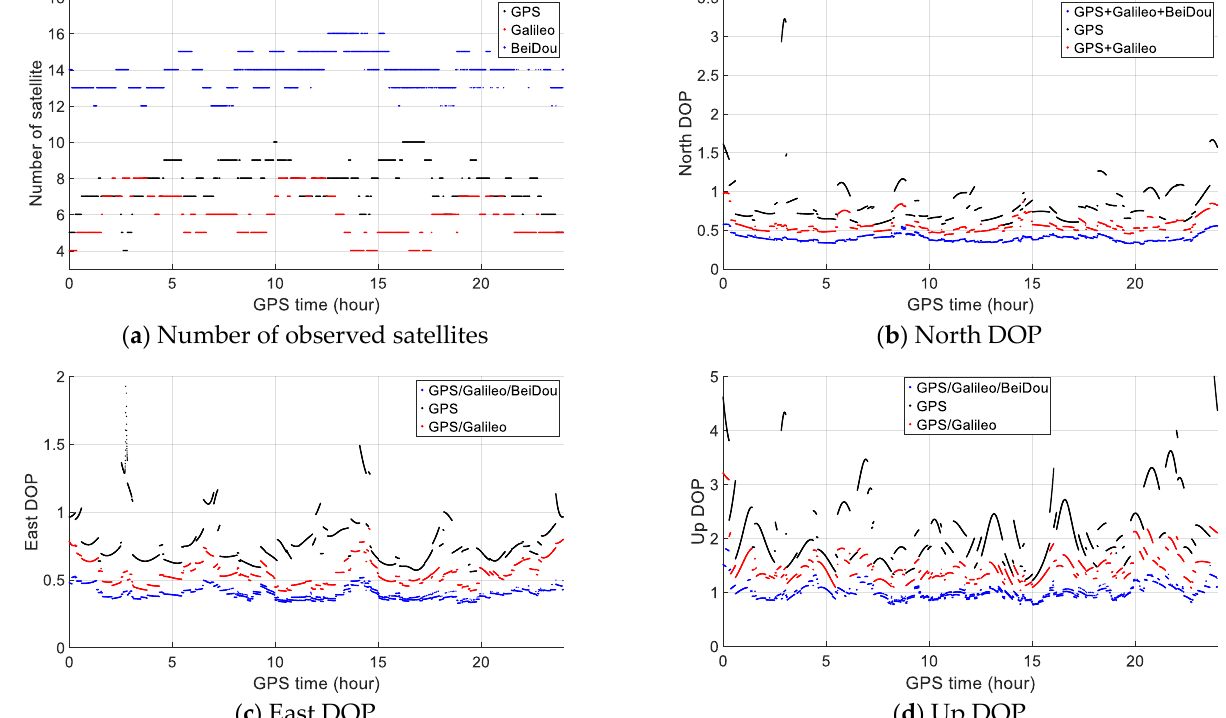
Figure 12. Number of observed satellites ( a ) and north ( b ), east ( c ) and up DOP ( d ). With the second proposed improving measure by preprocessing observations of any two neighboring epochs with the same parameters of broadcast ephemeris, the orbital and